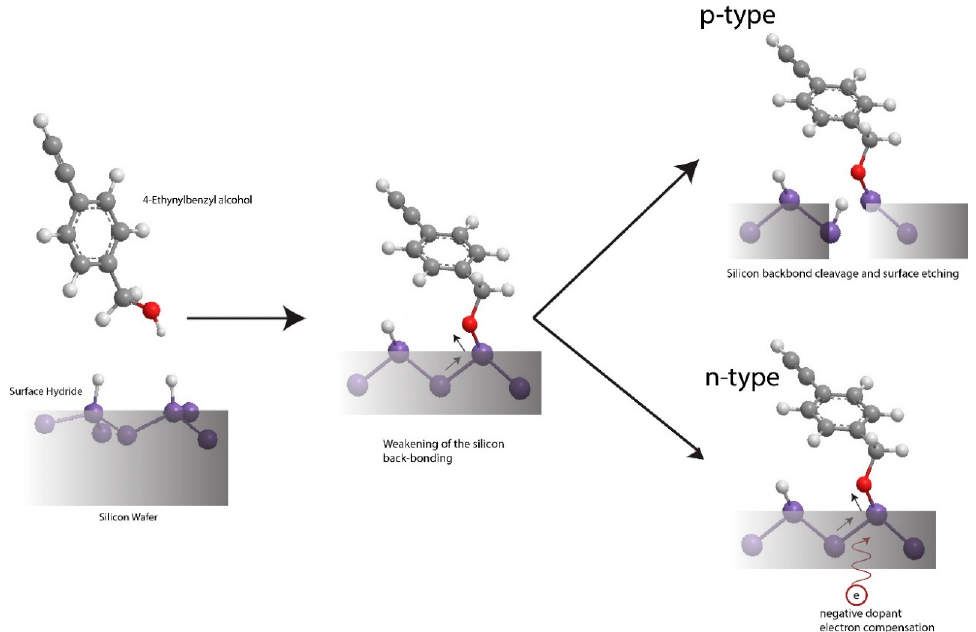
Figure 5. Schematic representation of the weakening of the Si–Si backbond on p -type and dopant compensation on the n -type silicon surface.